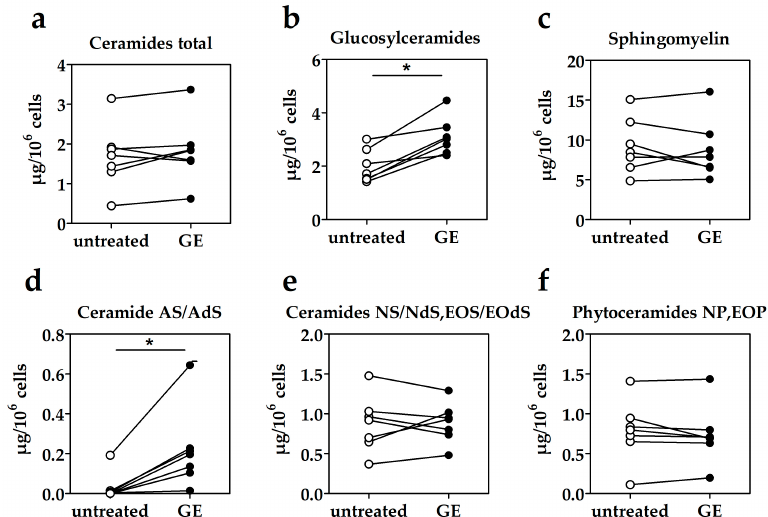
Figure 1. Effects of Gentiana lutea extract (GE) treatment on the concentrations of ceraimides and their precursors (glucosylceramides and sphingomyelins) in human primary keratinocytes (HPKs). HPKs were either treated for 1 week with GE (200 µg) or left untreated. ( a )–( f ) Lipids were analyzed by high performance thin layer chromatography (HPTLC). * p ≤ 0.05. Molecules 2020 , 25 , x FOR PEER REVIEW